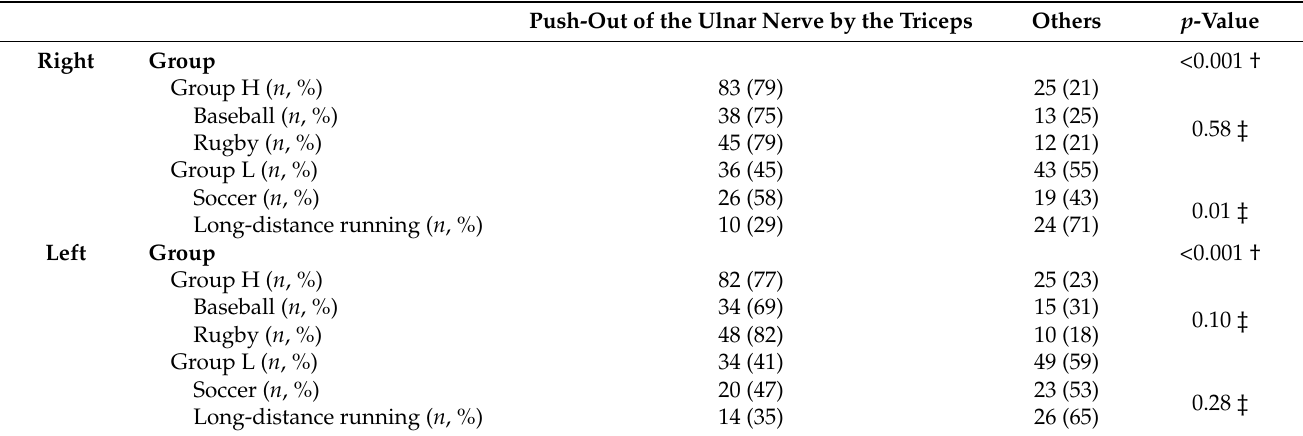
Table 6. Frequency of push-out of the ulnar nerve by the triceps from the cubital tunnel among groups H and L. Push-Out of the Ulnar Nerve by the Triceps Others p